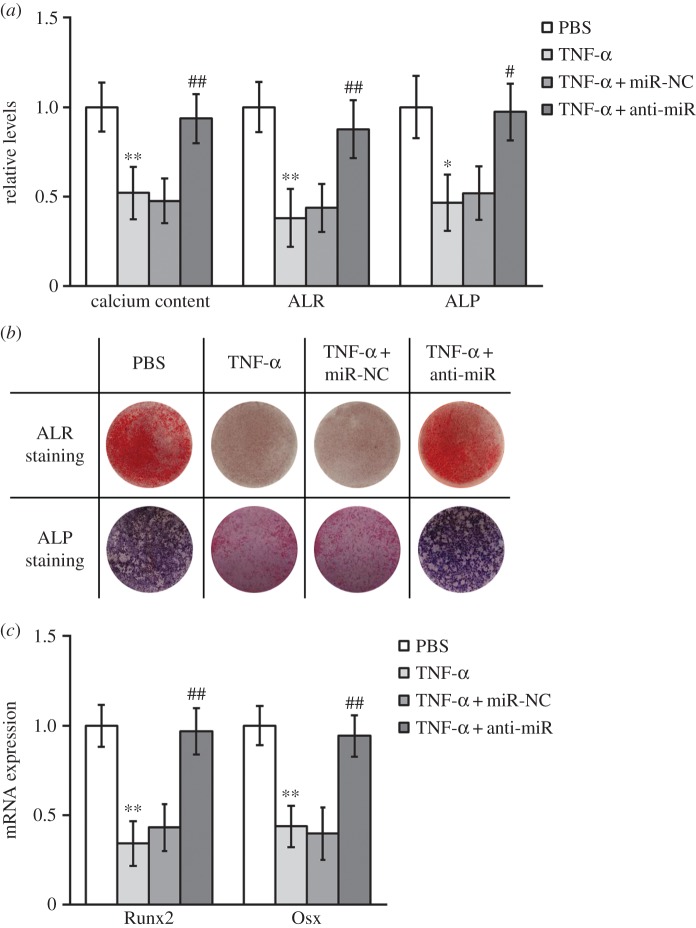
MiR-150-3p was required for TNF-α-induced inhibition of hBM-MSC osteogenic differentiation. (a) hBM-MSCs were transfected with either miR-NC (as control) or miR-150-3p inhibitor (anti-miR), then treated with either PBS (as control) or TNF-α, followed by measurements of calcium content, alizarin red (ALR) and alkaline phosphatase (ALP) stainings. (b,c) Representative images of ALR and ALP stainings (b), and expressions of Runx2 and Osx (c) after the same treatment as in (a). For the easy of comparison, results from figure 5 (PBS and TNF-α treatments) were also plotted. Data presented as mean ± s.d. from at least three independent experiments. **p < 0.01, *p < 0.05 compared with respective PBS control. ##p < 0.01, #p < 0.05 compared with respective miR-NC control.